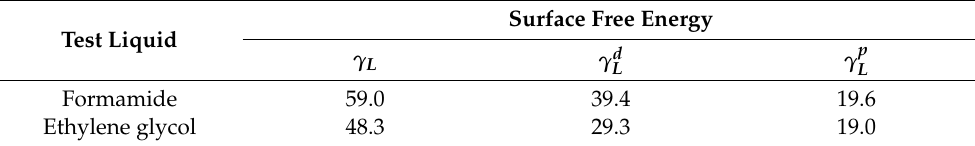
Table 4. Surface free energy of the test liquid and its